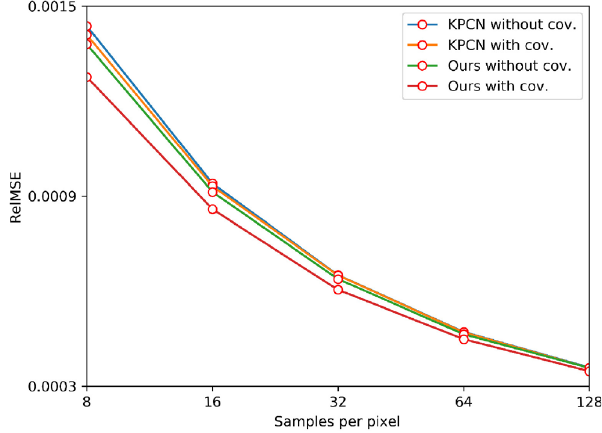
Fig. 10 RelMSE comparison between our method (with light transport covariance), our method (without light transport covariance), KPCN (without light transport covariance), and KPCN (with light transport covariance) for varying sample counts.